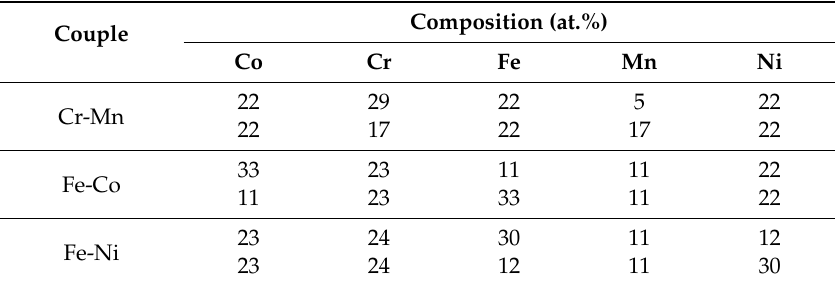
Table 3. Composition of the end members in di ff usion couples used by Tsai et al. [28]. Composition (at.%) Couple Co Cr Fe Mn Ni